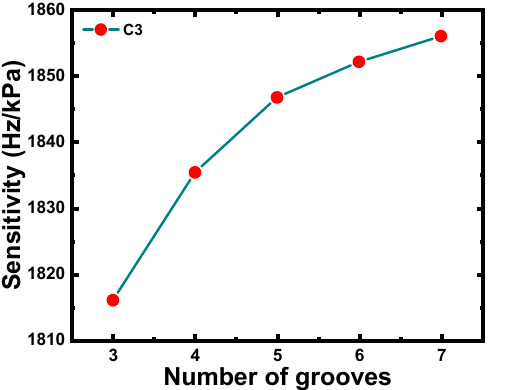
Figure 10. Pressure sensitivity of C3 with different numbers of grooves ( t i = 3.5 µ m, g 1 = 3.5 µ m, g 2 = 3.5 µ m ).